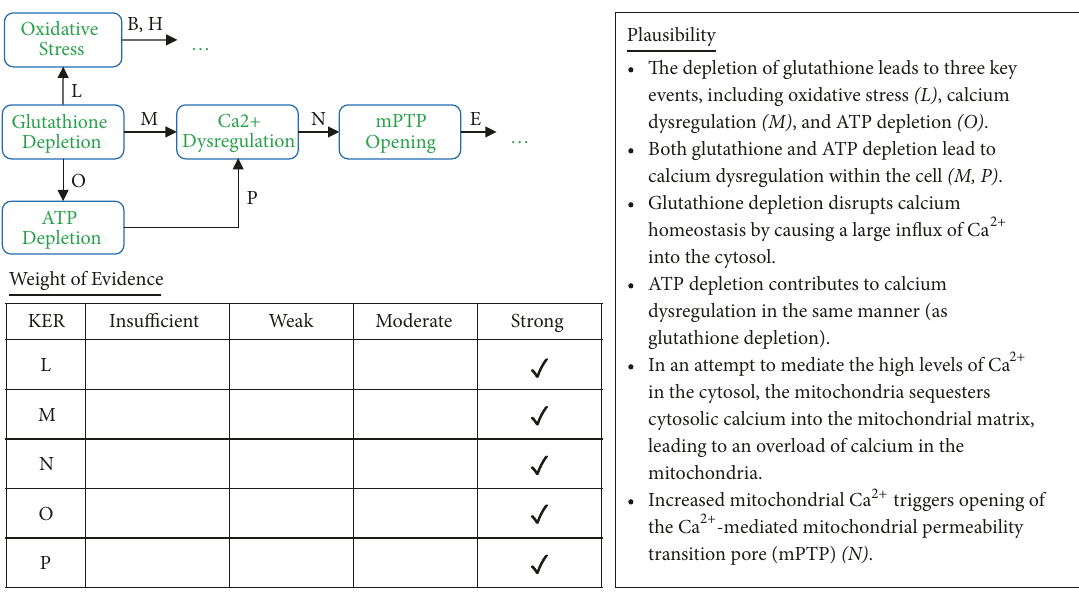
lists the physicochemical characteristics of three notable organohalogens (i.e., chloroform, trichloroacetic acid, and trichlorophenol) that are believed to inhibit the normal function of mitochondria in mammalian